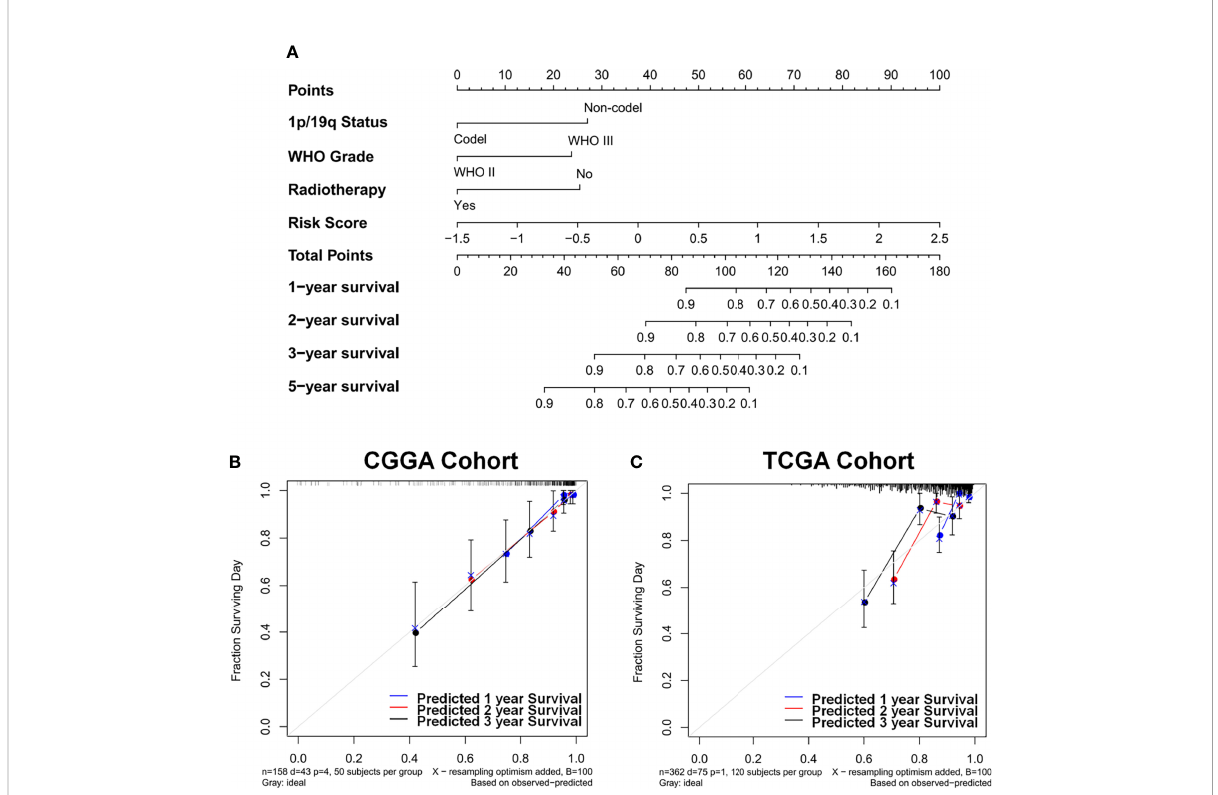
FIGURE 5 Identi fi cation and construction of the nomogram to estimate the overall survival for LGG patients. (A) The constructed nomogram estimated the risk of patients ’ prognosis for 1, 2, 3, and 5 years in CGGA cohort. Calibration curves showed the calibration of each model in terms of the agreement between the estimated and observed 1-year (blue), 2-year (red), and 3-year (black) outcomes in CGGA (B) and TCGA (C) datasets. Diagonal line presents a perfect estimation of an ideal model, while colored lines stand for the performance of the nomogram. A closer distance to the diagonal line represents a better estimation. LGG, lower-grade glioma; CGGA, Chinese Glioma Genome Atlas; TCGA, The Cancer Genome